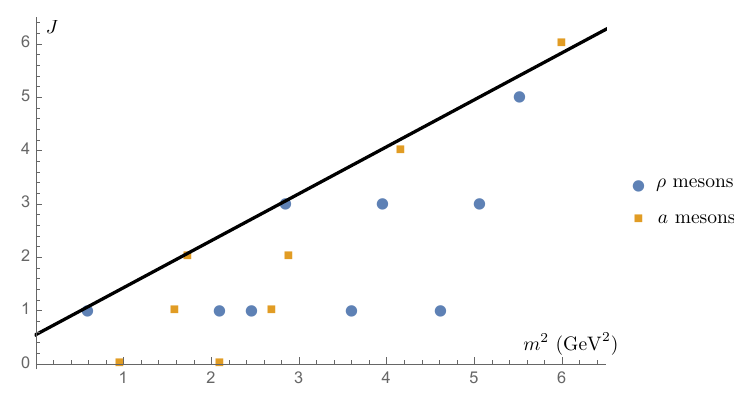
Figure 1 . A Regge plot of (cid:26) and a mesons, showing the leading trajectory